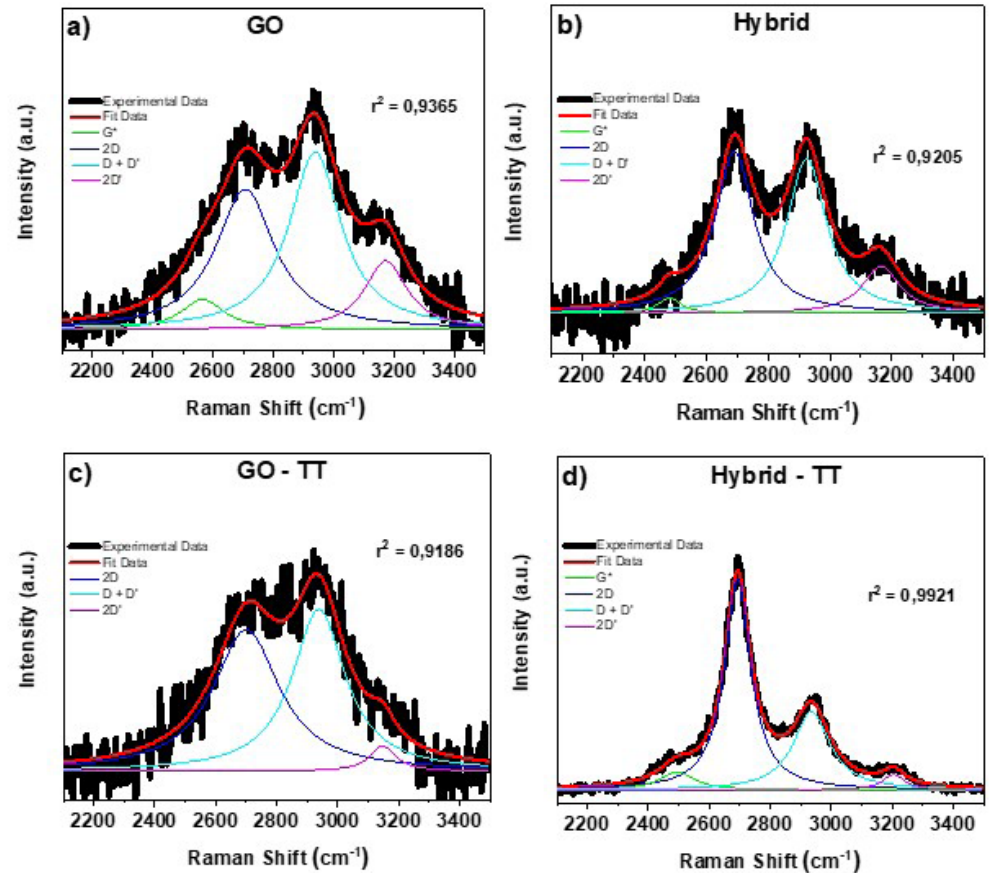
Figure 8. Raman spectra in the range of 2100 cm -1 to 3500 cm -1 (2D band region) of the pure GO and hybrid paper-likes untreated ( a-b ) and treated thermally (TT) ( c-d ). The four functions (G*,2D, D+D’ and 2D′ bands) were adjusted for all the samples according to the protocol available in the literature 40,41 .